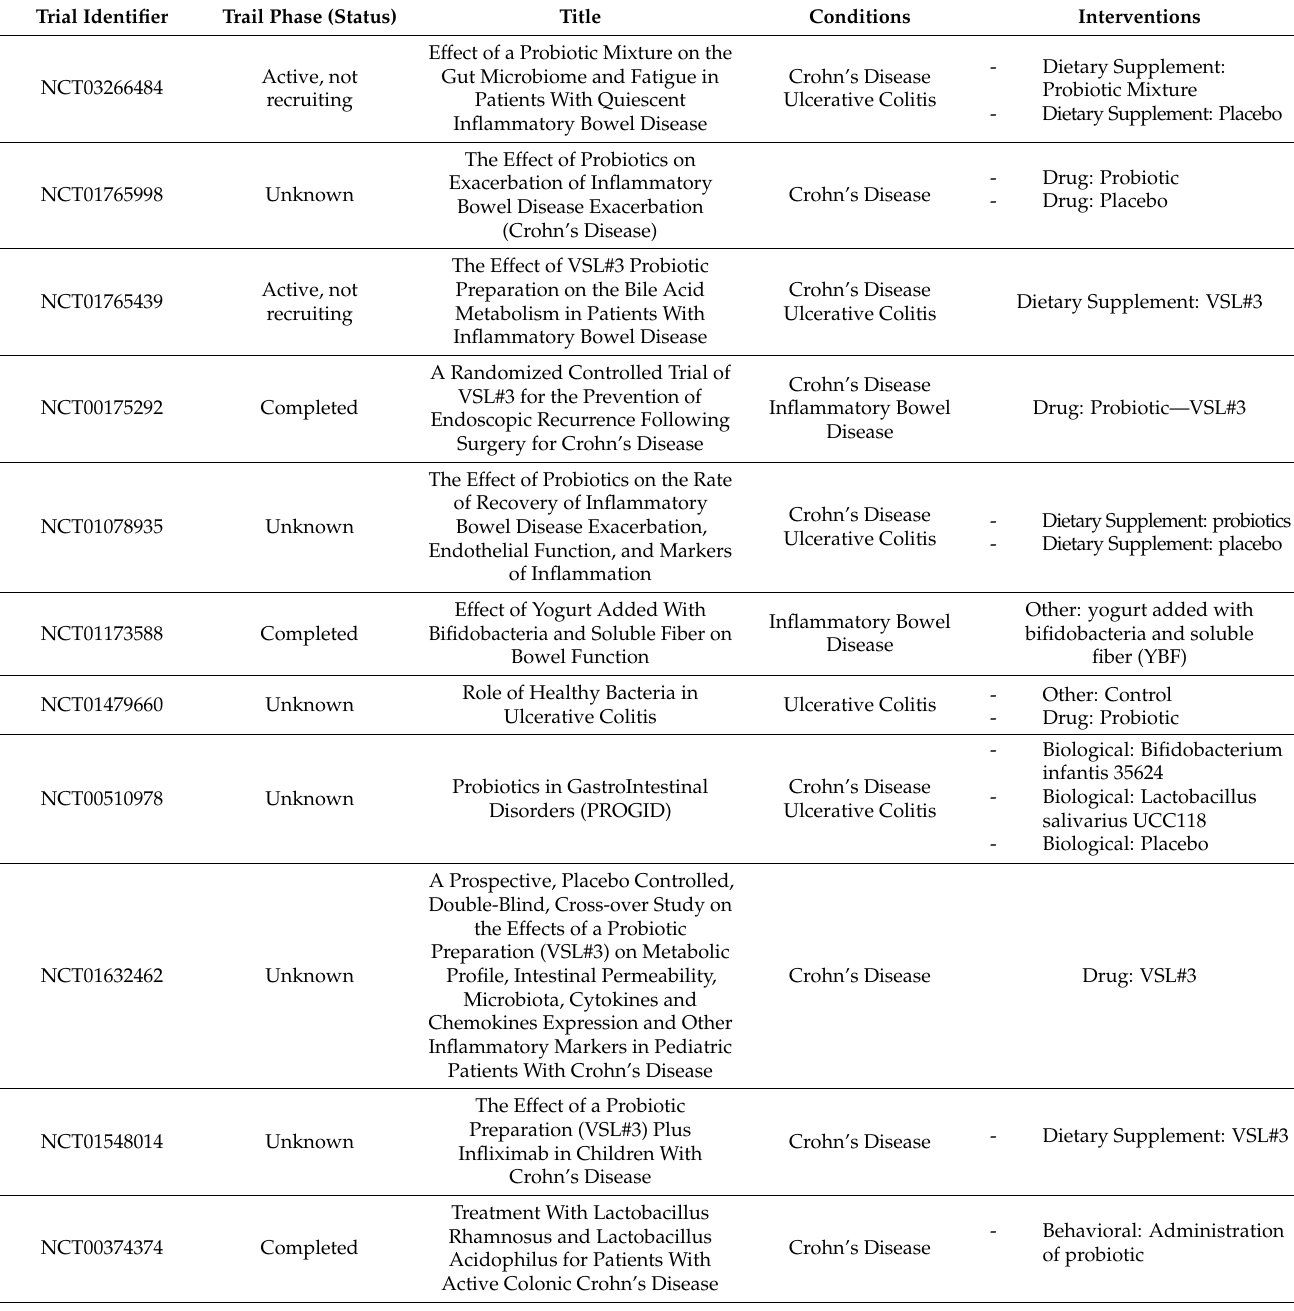
Table 1. Clinical Trials exploiting the use of Probiotics in